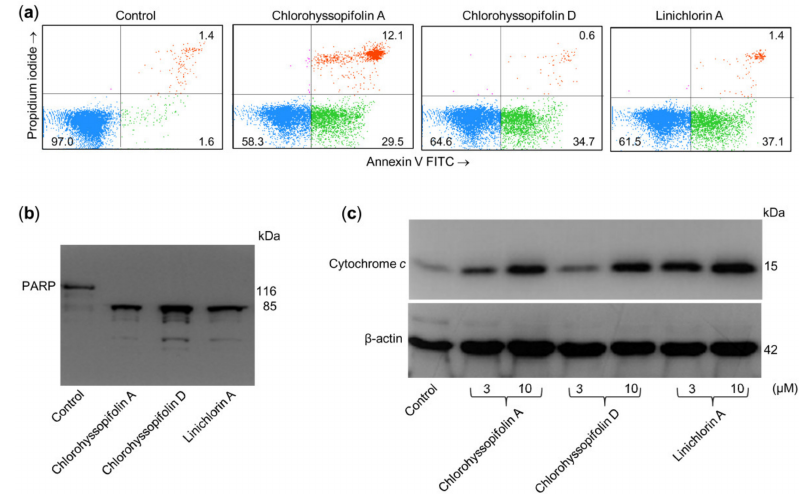
Figure 5. Chlorohyssopifolins A ( 1 ) and D ( 4 ) and linichlorin A ( 6 ) are potent apoptotic inducers in U-937 cells. ( a ) Cells were incubated in the presence of 10 µ M of the indicated guaianolides and subjected to flow cytometric analysis after double staining with Annexin V-FITC and propidium iodide. ( b ) Cells were treated as above and Poly(ADP-ribose) polymerase cleavage was determined using Western blot analysis. ( c ) Cytochrome c release induced by the specified compounds at the indicated concentrations was analyzed using Western